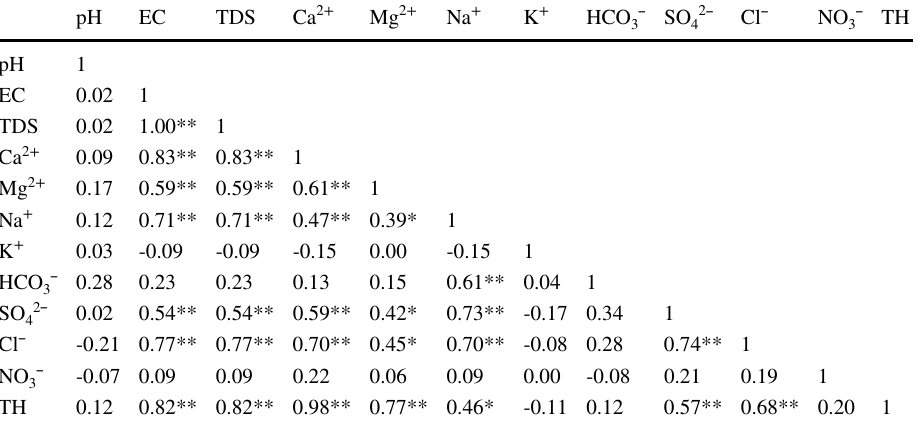
Table 7 Represents the correlation matrix results (Pearson) of physicochemical parameters in the studied shallow aquifer water samples